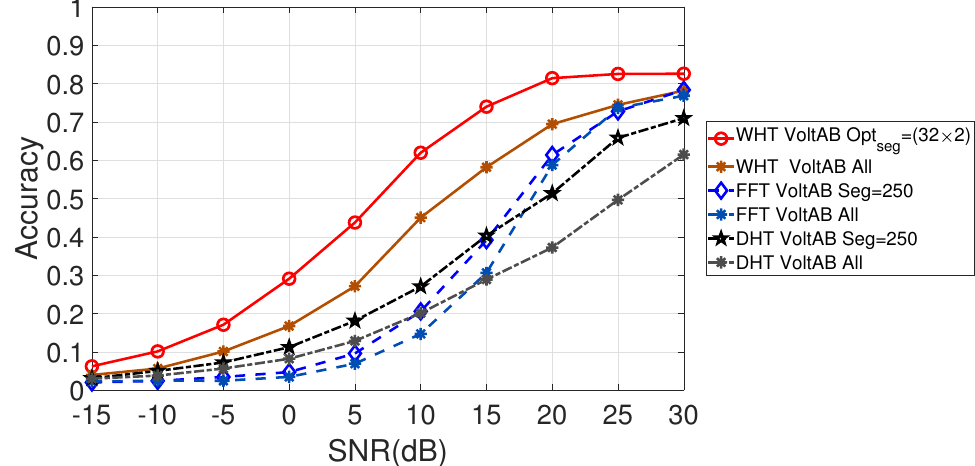
Figure 7. Accuracy trends with CNN for the different tranforms (WHT, FFT, and DHT) and different values of SNR in